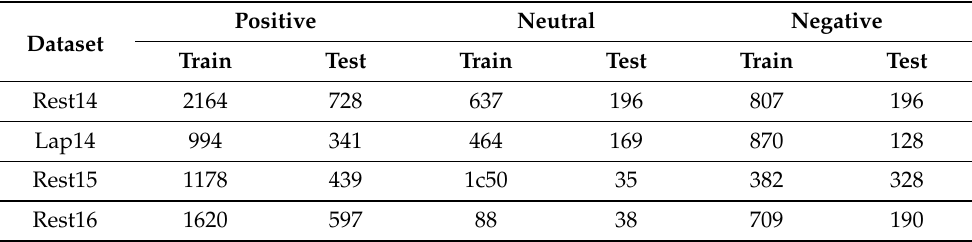
Table 1. Statistics of